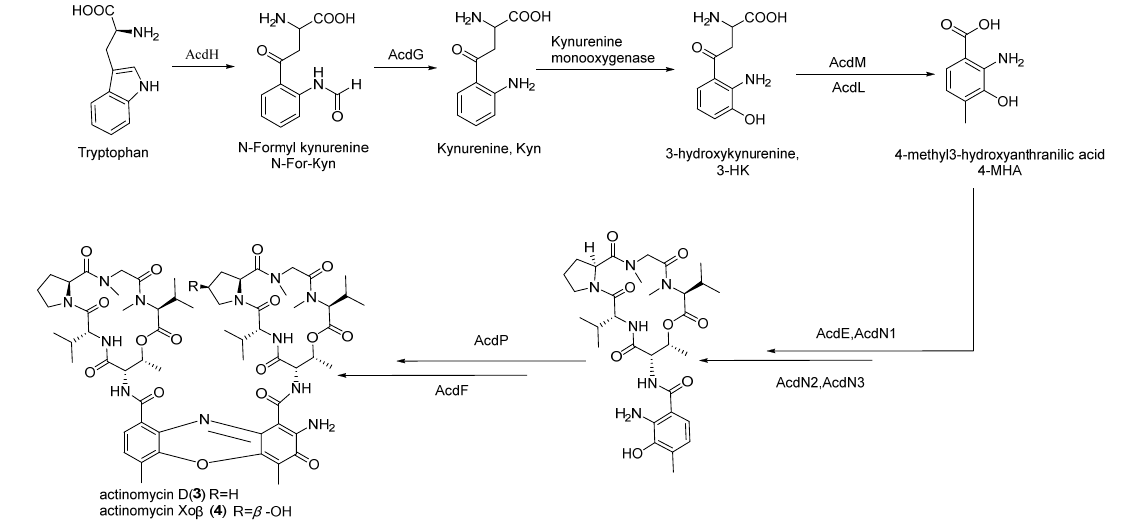
Figure 6. Proposed biosynthetic pathway of actinomycin in S. griseus SCSIO PteL053.